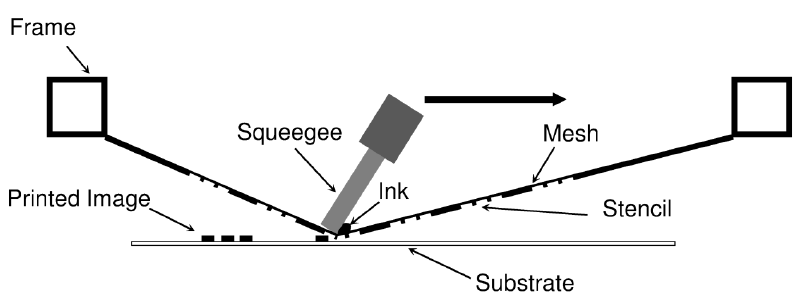
Figure 1. Schematic of screen printing